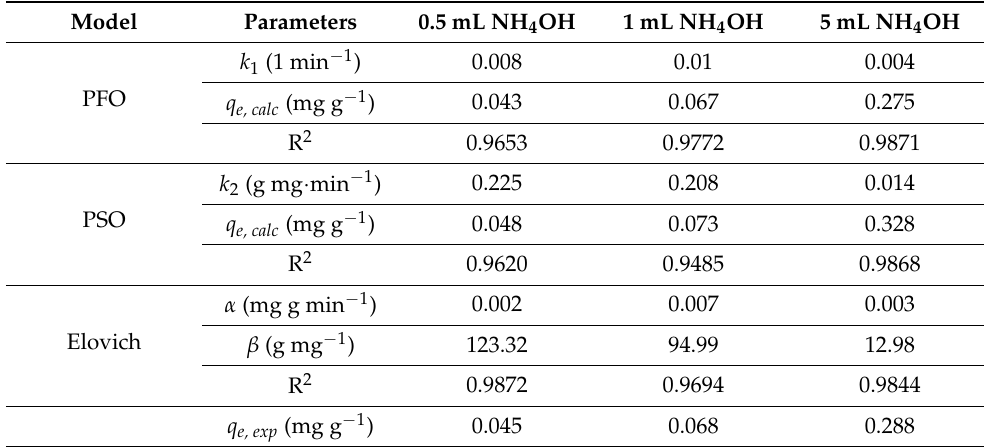
Table 4. PFO, PSO, and Elovich parameters and correlation coefficients of NH 3 adsorption onto thermally treated volcanic tuff obtained by nonlinear